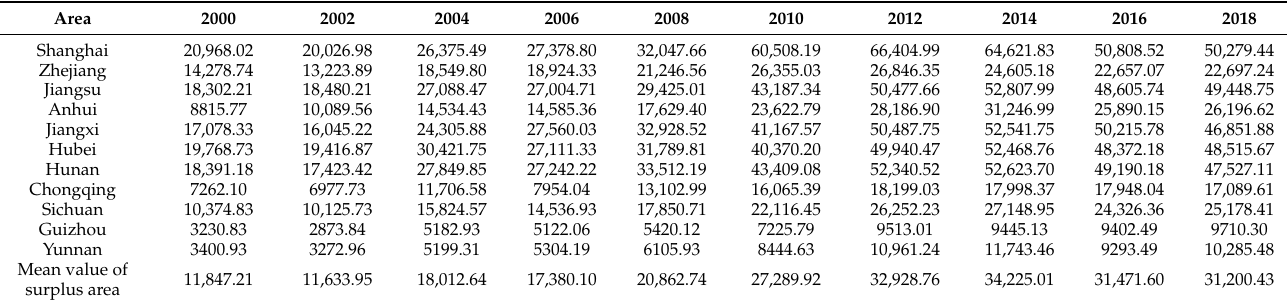
Table 2. The net value of ecosystem service of cultivated land in the Yangtze River Economic Belt from 2000 to 2018 (CNY/hm 2